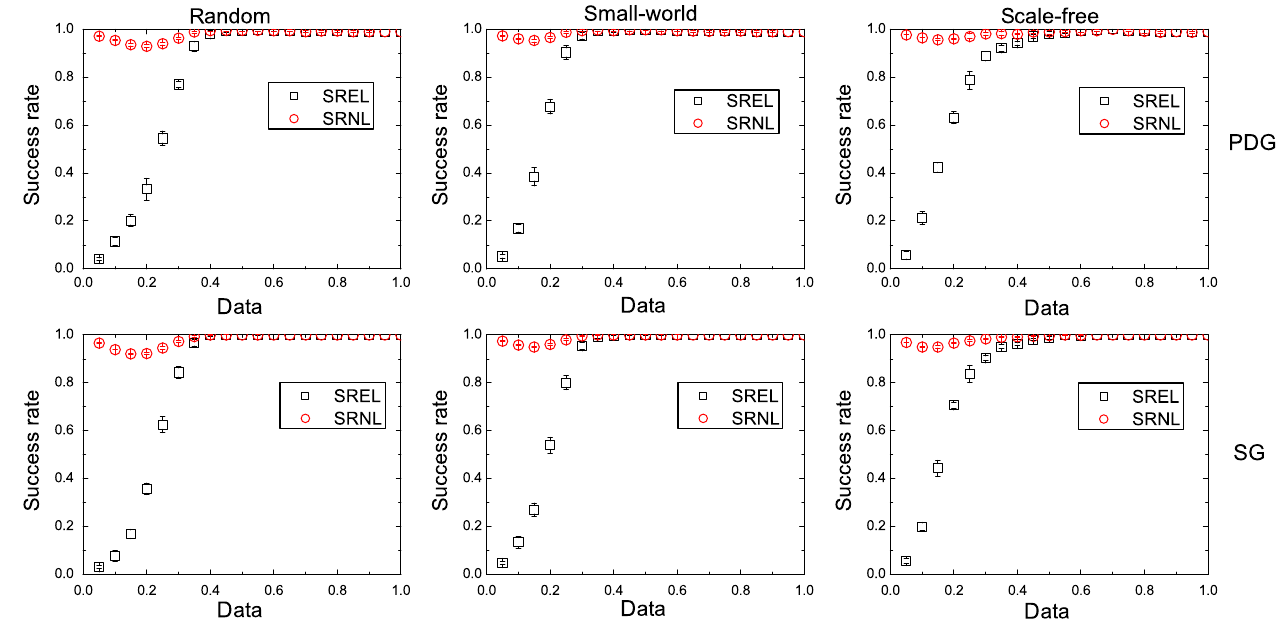
FIG. 1. Success rates of inferring three types of networks: random, small-world and scale-free, with PDG and SG dynamics. The network size N is 100. Each data point is obtained by averaging over 10 network realizations. For each realization, measurements are randomly picked from a time series of temporary evolution. The error bars denote the standard deviations. The payoff parameters for the PDG and the SG are b ¼ 1 : 2 and r ¼ 0 : 7 , respectively. We have also systematically tested other values of b and r and obtained similar success rates. The average node degrees of all used networks are fixed to 6 and the noise parameter (cid:1) ¼ 0 : 1